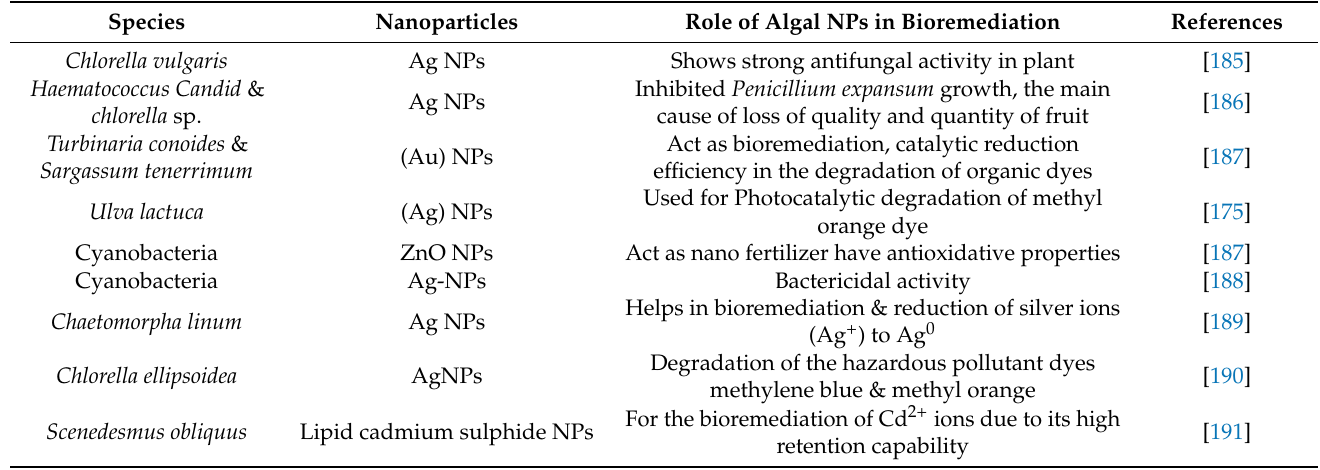
Table 5. Role of algal mediated nanoparticles in bioremediation and nano